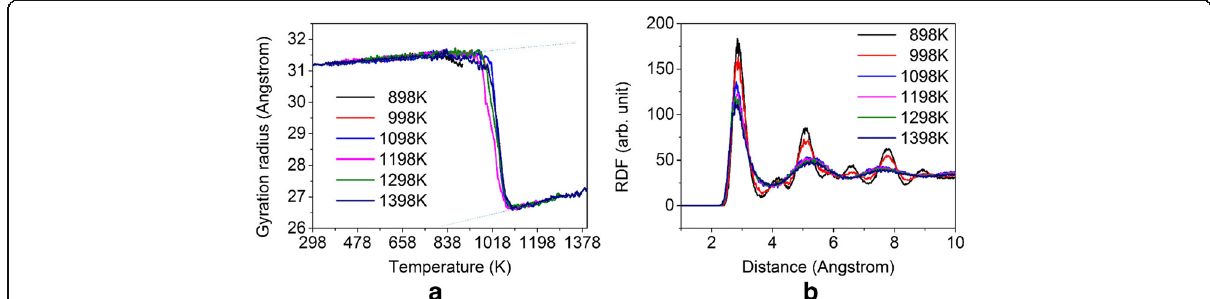
Fig. 5 Influence of the maximum heating temperature. a Gyration radius as a function of temperature during the heating process. b The final radial distribution function (RDF) of the systems with different maximum temperatures. Dashed lines in ( a ) indicate the slope of the curve at different heating